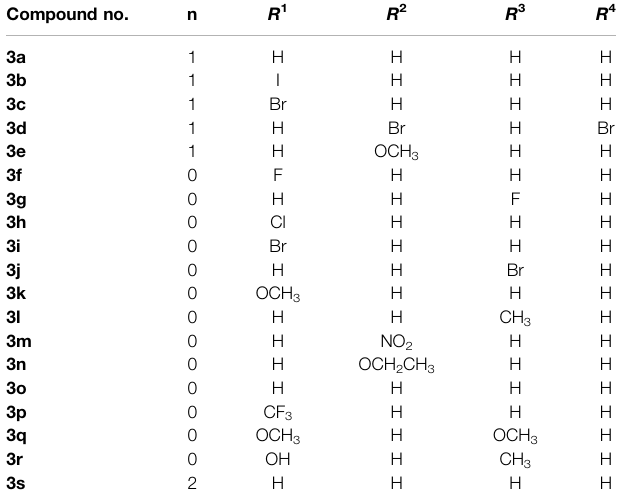
TABLE 1 | Structures of compounds 3a-3s . Compound no.